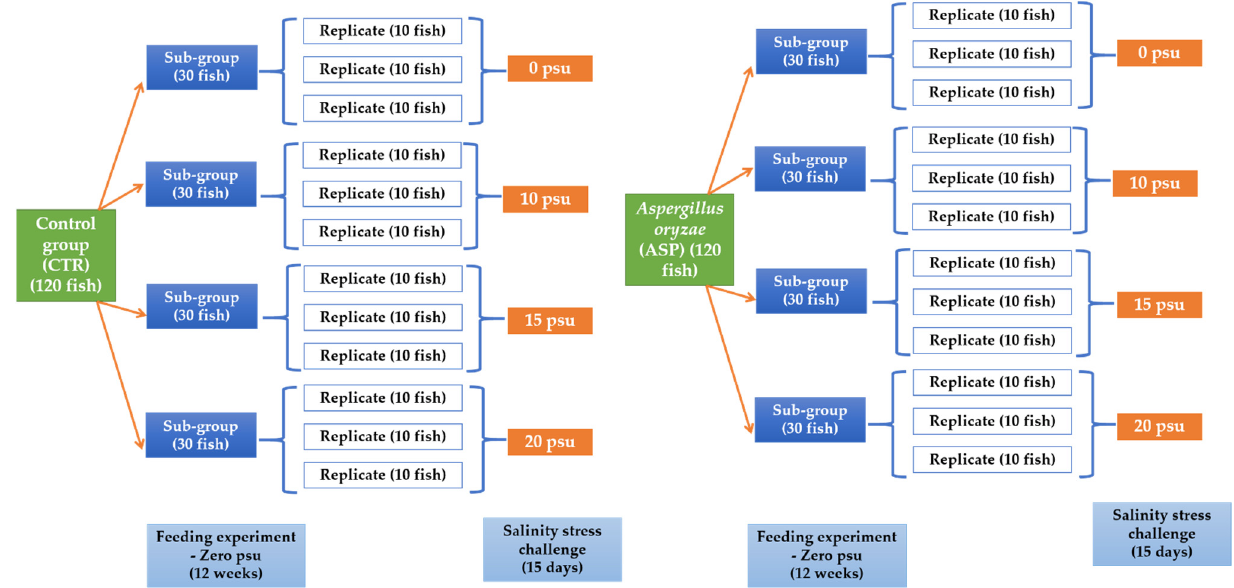
Figure 1. Experimental design of the present study showing the two experiments (feeding trial and salinity stress chal- lenge).